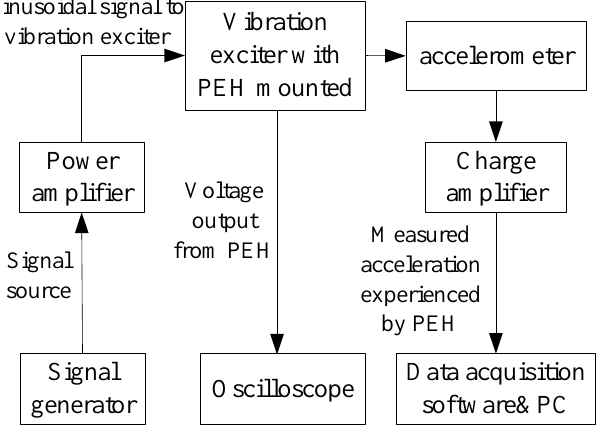
Figure 10. S chematic drawing of the experimental setup for PEH system.